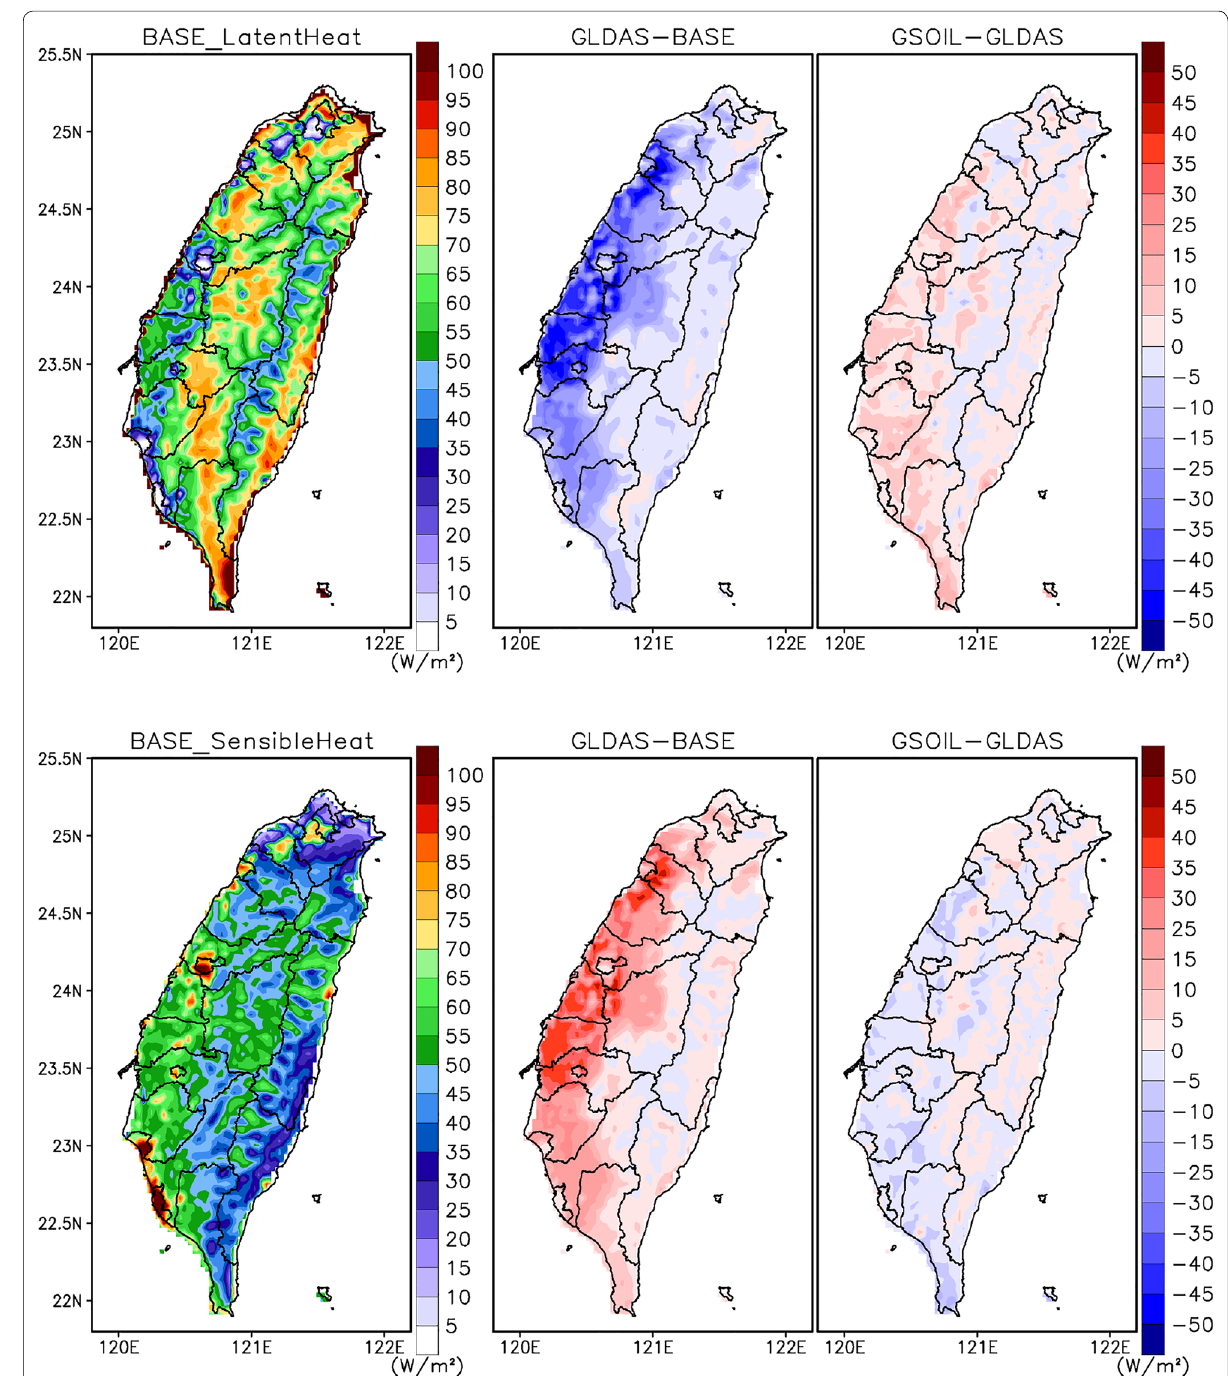
Fig. 6 LHF (top) and SHF (bottom) averaged from 6‑month simulation. Left to the right are from the WRF‑base run, difference between WRF‑GLDAS and WRF‑base, difference between WRF‑GSOIL, and